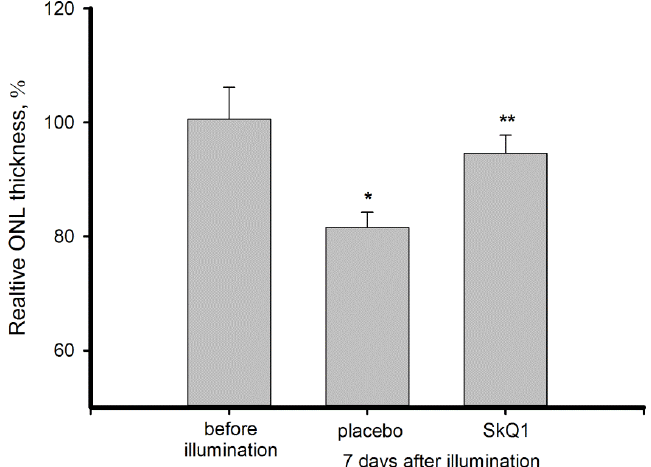
Figure 1. Normalized outer nuclear layer (ONL) thickness in the illuminated retinas of rabbits with or without premedication with 7.5 μM SkQ1. ONL thickness in the intact retinas is taken as 100%. Each bar represents the data obtained from six animals (12 eyes). * p ≤ 0.05 compared with the values measured in the intact animals; ** p ≤ 0.05 compared with the values measured in the control animals.